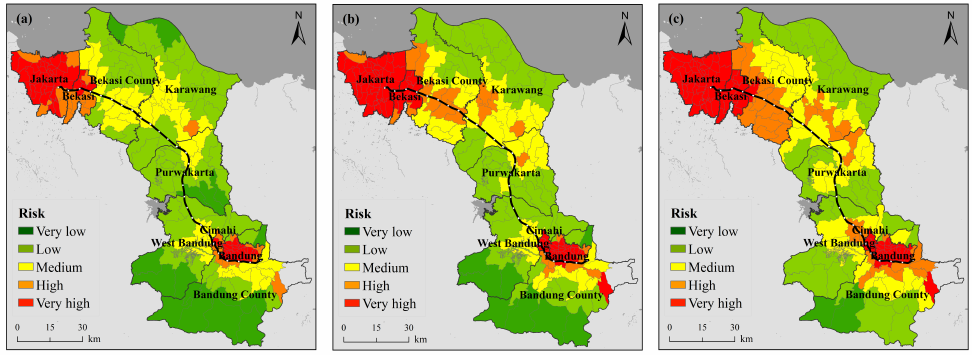
ArcGIS was applied to spatially link HWR raster data with subdistrict vector data to obtain a map of the HWR levels at the subdistrict scale (Figure 7).